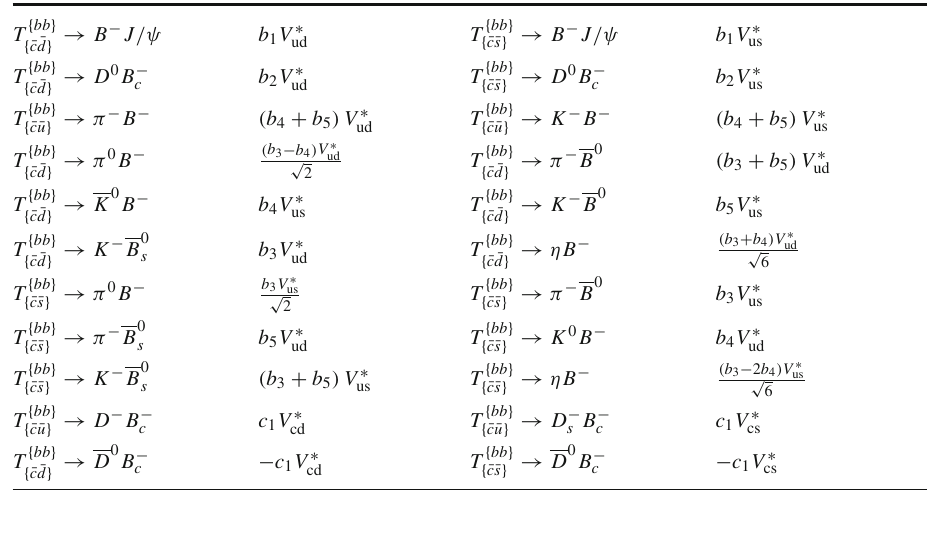
{ bb } Table 5 Tetraquark T {¯ c ¯ q } decays into B c plus light meson or anti-charm plus B meson induced by the charmless transition b → d or b → s